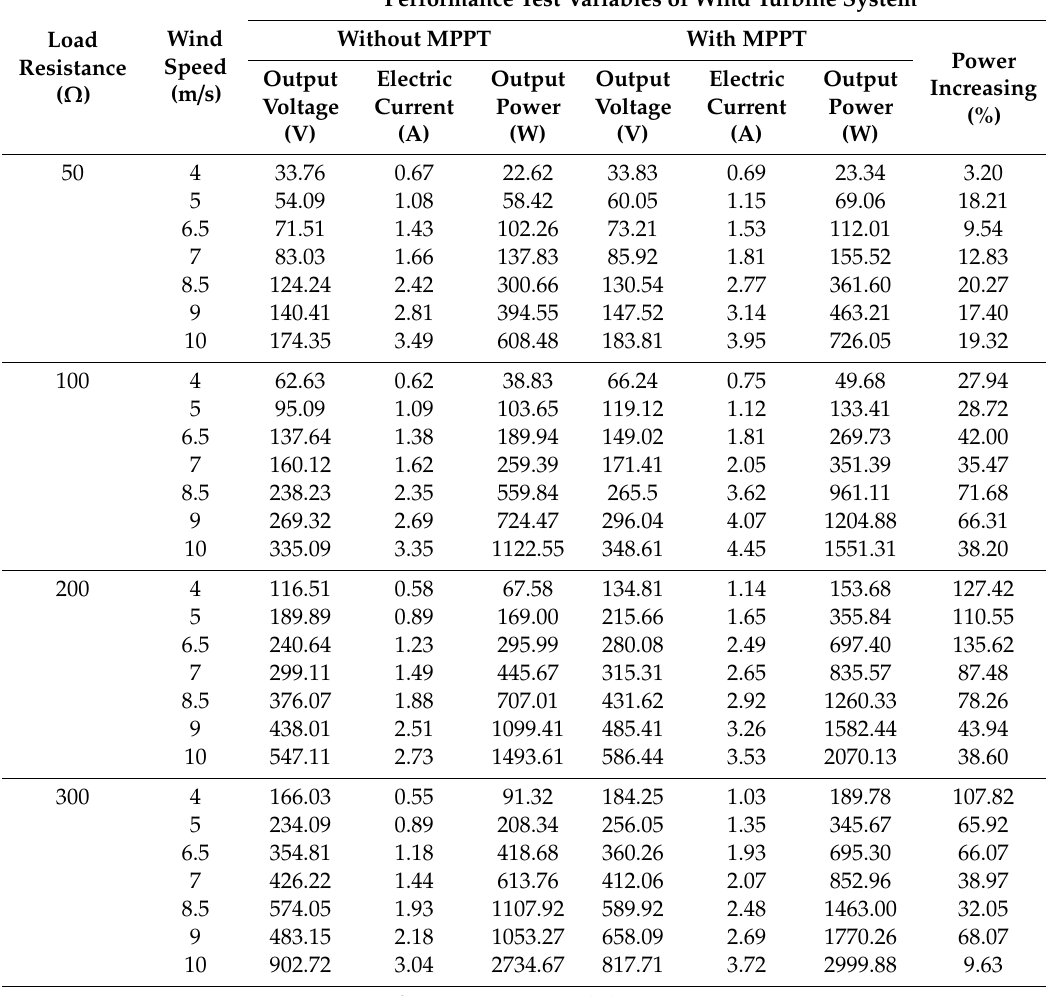
Figure 13. Wind-turbine system with MPPT in Simulink-Matlab software. Table 8. Results of performance test of wind-turbine